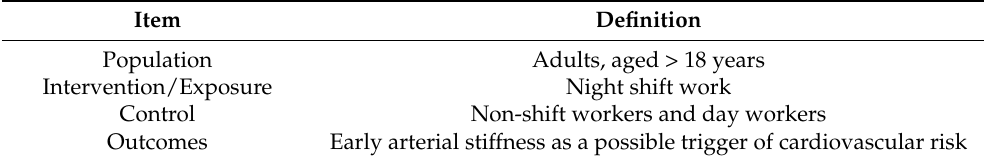
Table 1. Research question devised using PICO strategy.